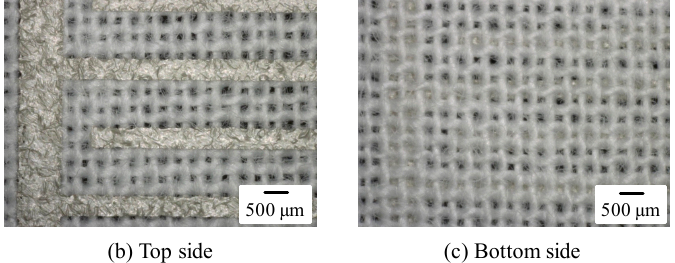
Figure 2. ( a ) Textile-based blood leakage sensor, and microscopy images of its ( b ) top and ( c ) bottom.